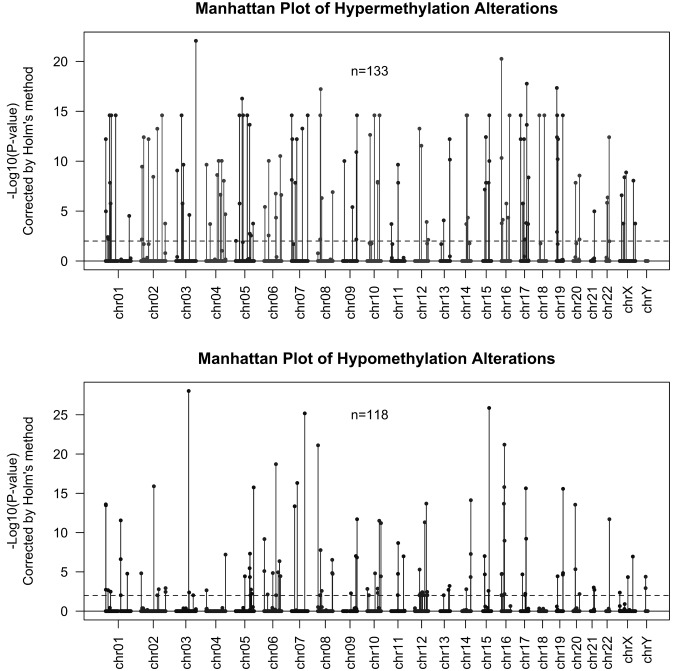
Manhattan plots of the frequency of hypermethylation alterations (upper graph) and the frequency of hypomethylation alterations (lower graph) in the 14 analyzed UC samples. The p-values were calculated by a binomial test based on the frequency of alterations empirically obtained from every individual sample, under the null hypothesis that every probe had the same probability of being altered within a sample. P-values were subsequently corrected for multihypothesis testing by Holm’s method. The dashed horizontal line represents the applied statistical significance level, set at P=0.01.